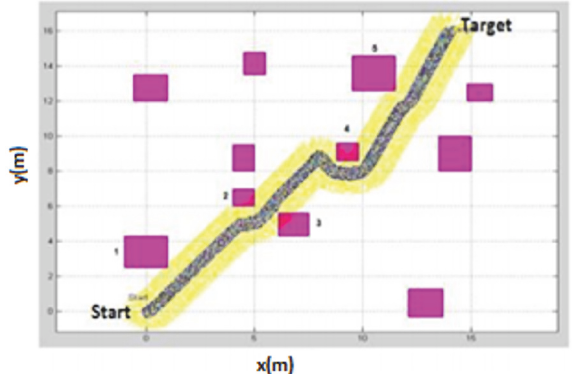
Figure 9: Controlling the local minima problem of APF in path planning and obstacle avoidance by optimizing APF using PSO algorithm (source